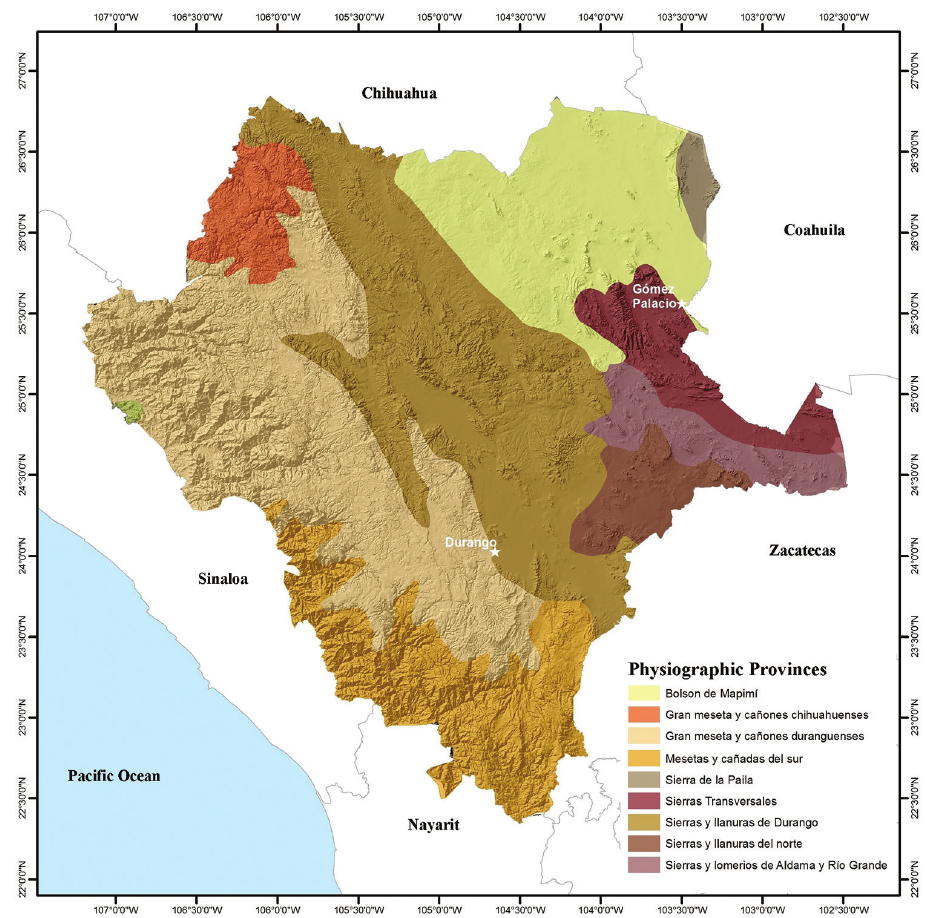
Figure 2. Physiographic provinces of the state of Durango, Mexico (modified from Cervantes- Zamora et al.